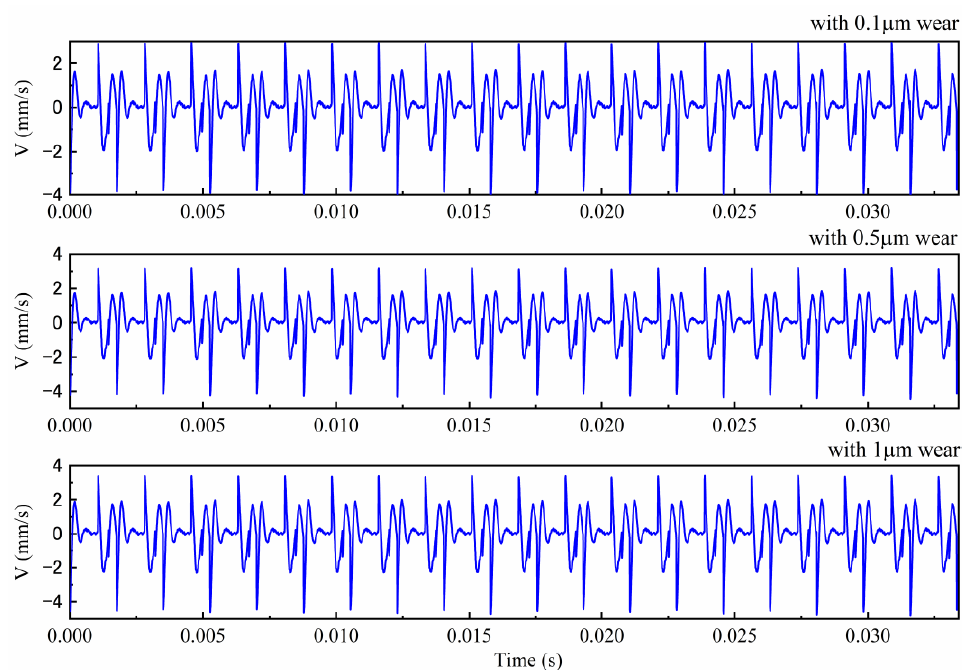
. y under different wear p